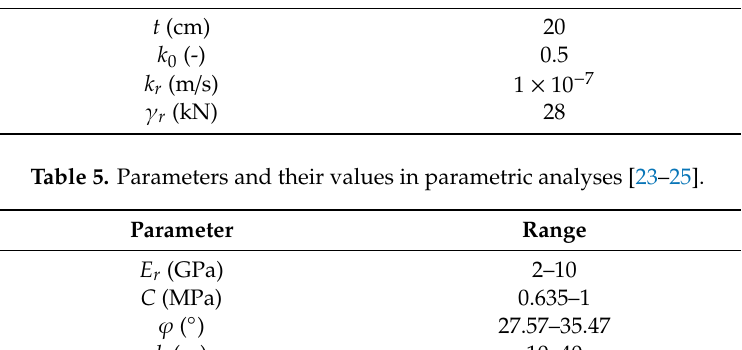
Figure 4. Effective parameters in the parametric study.